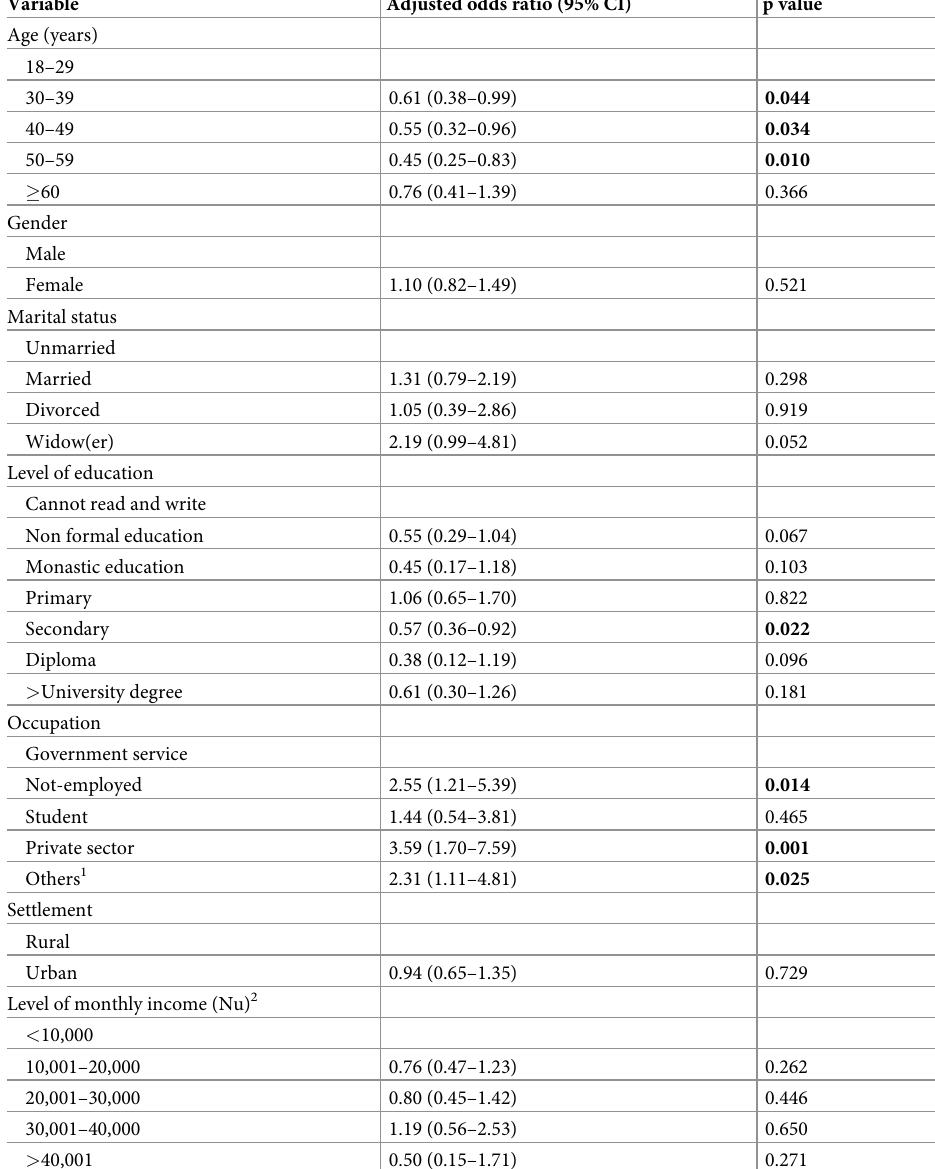
Table 3. Factors associated with good knowledge regarding COVID-19 preventive measures among participants surveyed for the knowledge, attitude and practices survey in Bhutan, January–February, 2022 (n = 1708).